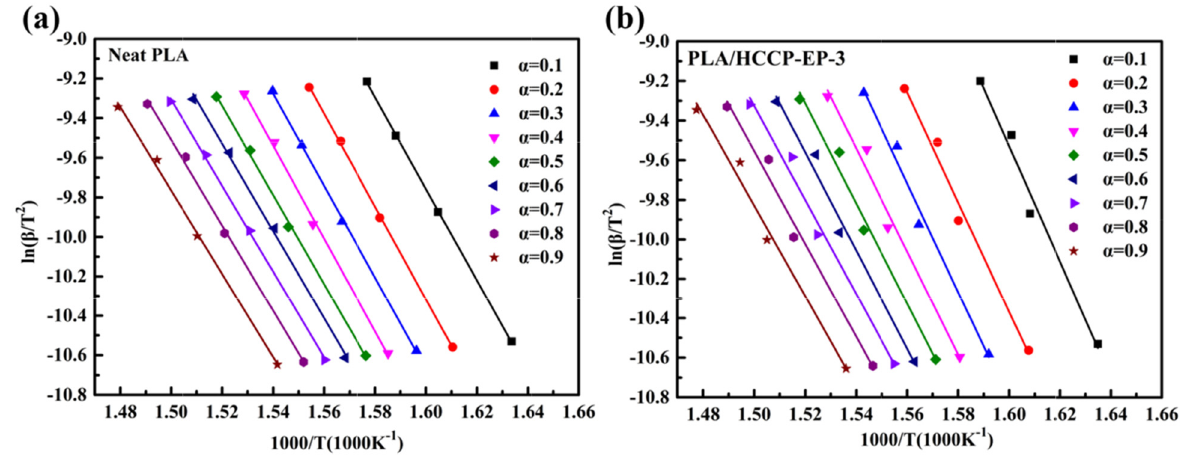
Figure 11: ( a ) Plot curves of ln ( β / T 2 ) against 1/ T of PLA under di ff erent α . ( b ) The plot curves of ln ( β / T 2 ) against 1/ T of PLA/HCCP - EP - 3 under di ff erent α .